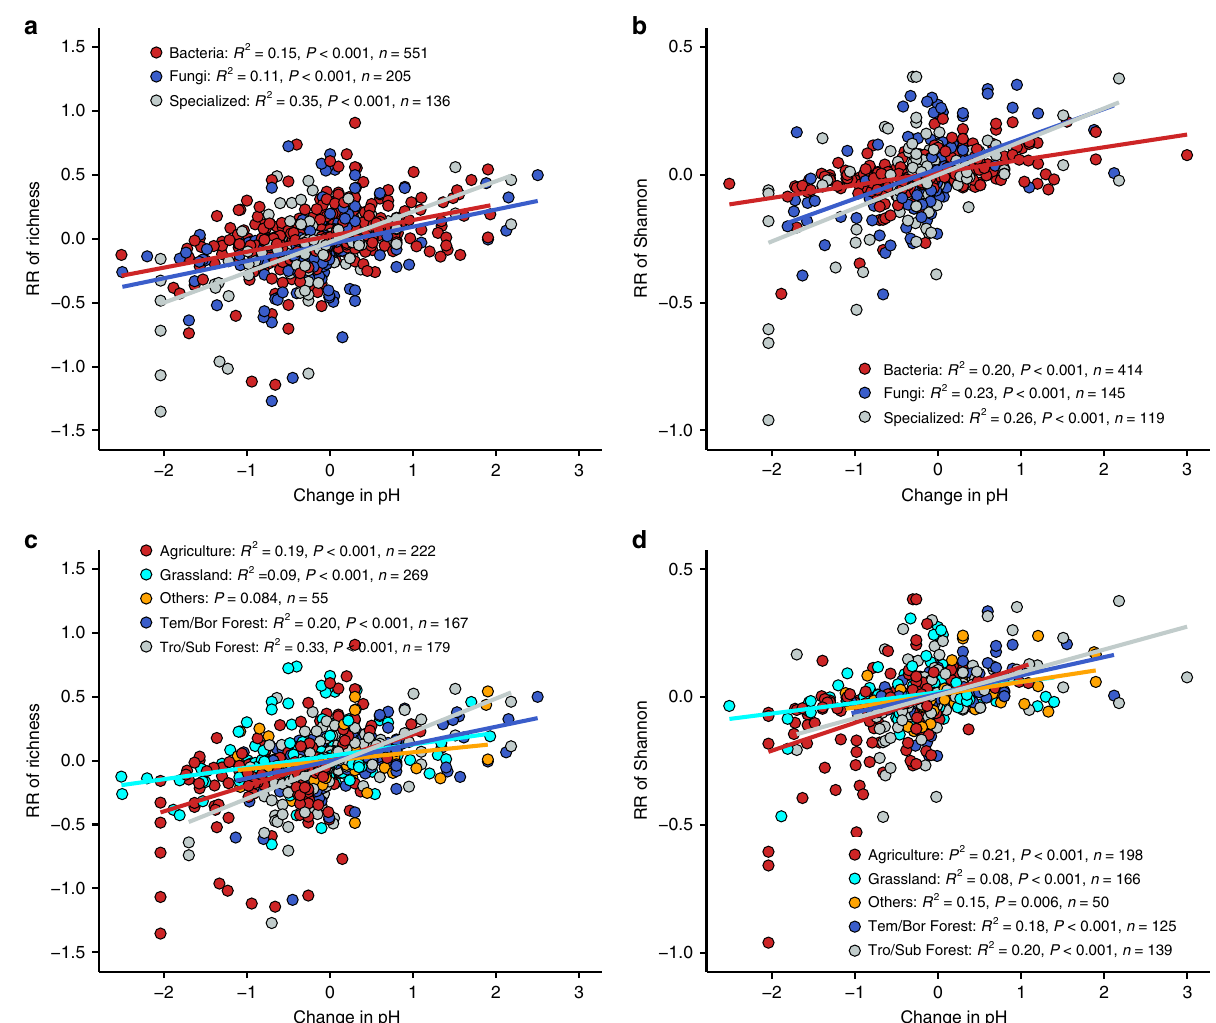
Fig. 4 Coordinated changes between soil pH and diversity. a Linear relationships between changes in soil pH and response ratio (RR) of richness by microbial groups (bacteria: y = 0.12 x + 0.02; fungi: y = 0.13 x − 0.04; specialized microbes: y = 0.24 x − 0.03). b Linear relationships between changes in soil pH and RR of Shannon index by microbial groups (bacteria: y = 0.05 x + 0.008; fungi: y = 0.12 x + 0.02; specialized microbes: y = 0.13 x − 0.0007). c Linear relationships between changes in soil pH and RR of richness by biome types (agriculture: y = 0.20 x + 0.003; grassland: y = 0.09 x + 0.04; others: insigni fi cant; temperate/boreal (Tem/Bor) forest: y = 0.13 x − 0.005; tropical/subtropical (Tro/Sub) forest: y = 0.26 x − 0.04). d Linear relationships between changes in soil pH and RR of Shannon index by biome types (agriculture: y = 0.11 x + 0.009; grassland: y = 0.04 x + 0.02; others: y = 0.05 x + 0.01; Tem/Bor forest: y = 0.07 x + 0.01; Tro/Sub forest: y = 0.90 x + 0.007). Source data are provided as a Source Data fi